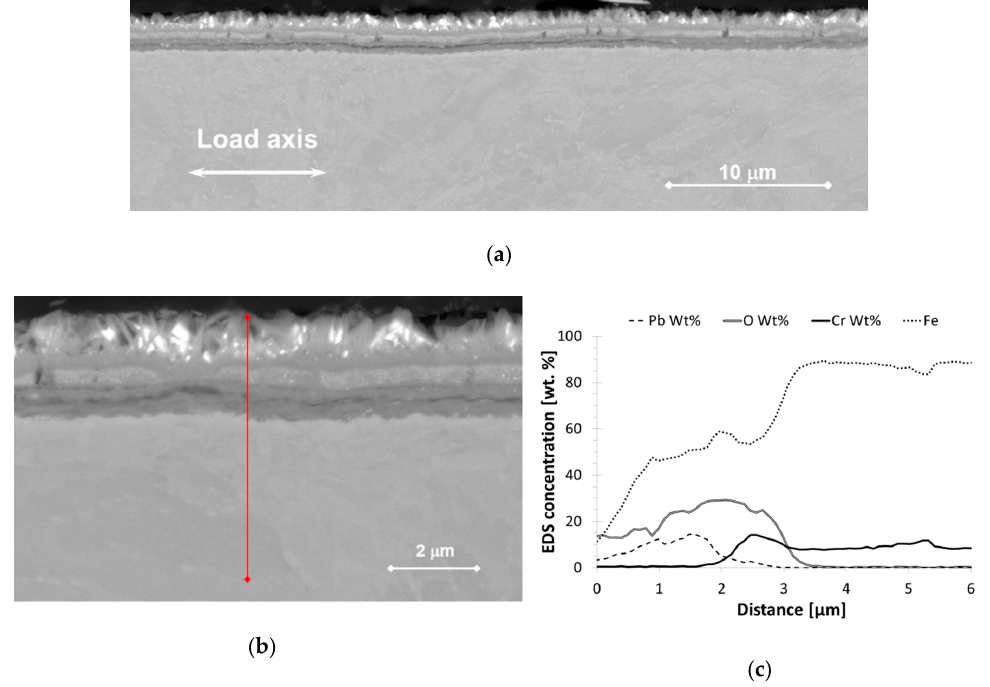
Figure 11. Tapered specimen T38 (R2) after testing in liquid Pb and chemical cleaning: ( a ) Cross section showing the oxide on the ground surface outside the minimum (BSE); ( b) detail of (a); ( c ) EDS line scan across the oxide scale.